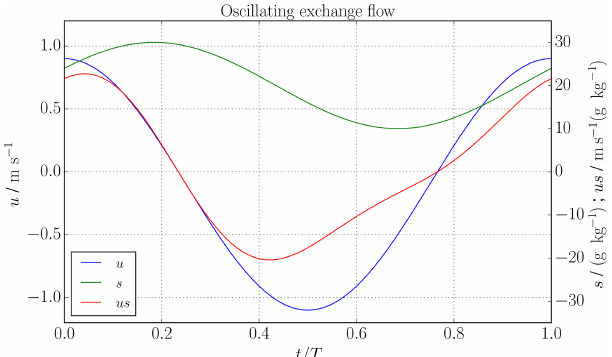
Figure 1. Oscillating exchange flow (see Sect. 2): time series of velocity (blue), salinity (green) and salinity flux (red) for the oscil- lating exchange flow scenario